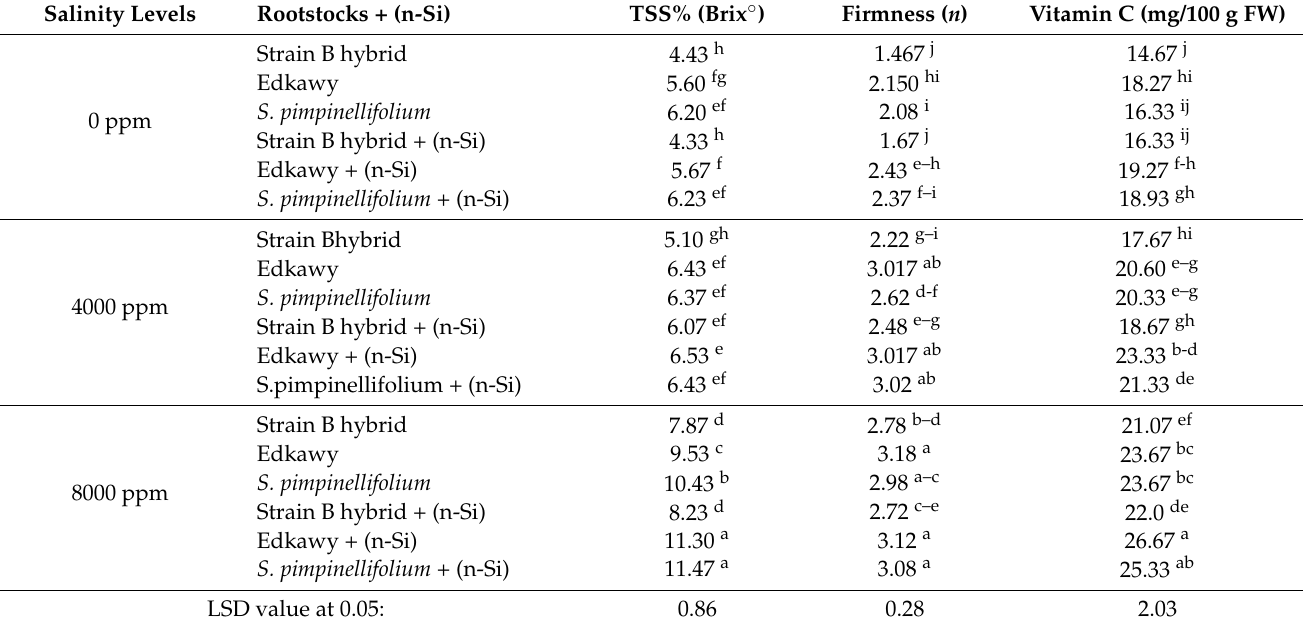
Table 2. Effect of water salinity, grafting, foliar application of nano-silicon (n-Si), and their interactions on the quality parameters of tomato fruits (combined 2020 and 2021